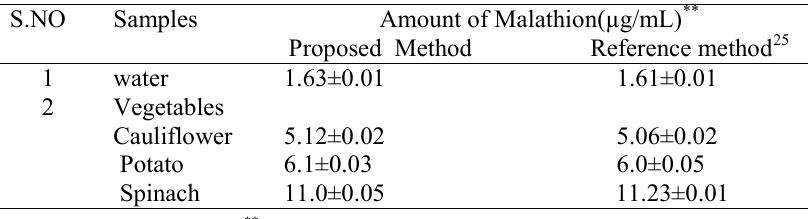
Table 1. Determination of malathion in water and vegetables.